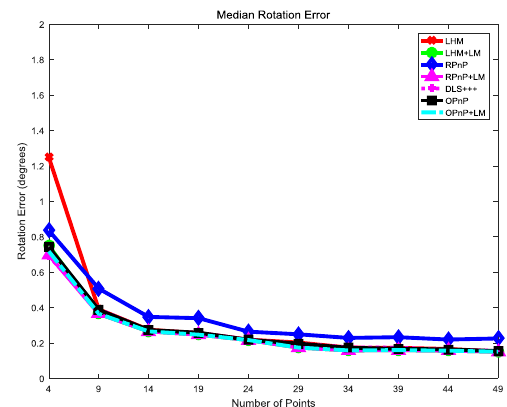
Figure 2. Median rotation error w.r.t. varying number of points